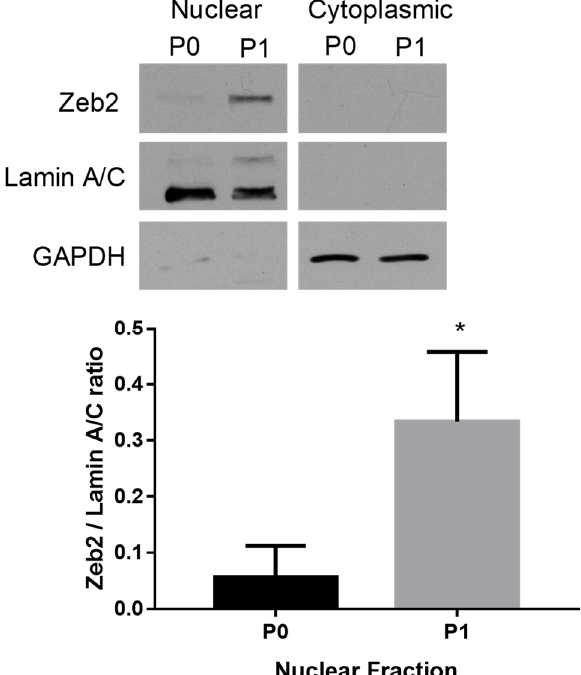
Figure 1. Zeb2 is localized to the nuclei of primary rat cardiac myofibroblasts. Zeb2 protein expression was enriched in the nuclear fraction from P1 rat cardiac myofibroblasts as compared to P0. Lamin and GAPDH were used as nuclear and cytoplasmic loading controls, respectively. The data shown are from n = 4 independent experiments, * p ≤ 0.05 vs. P0. Error bars represent SEM. Data were analyzed by performing Student’s t -test.